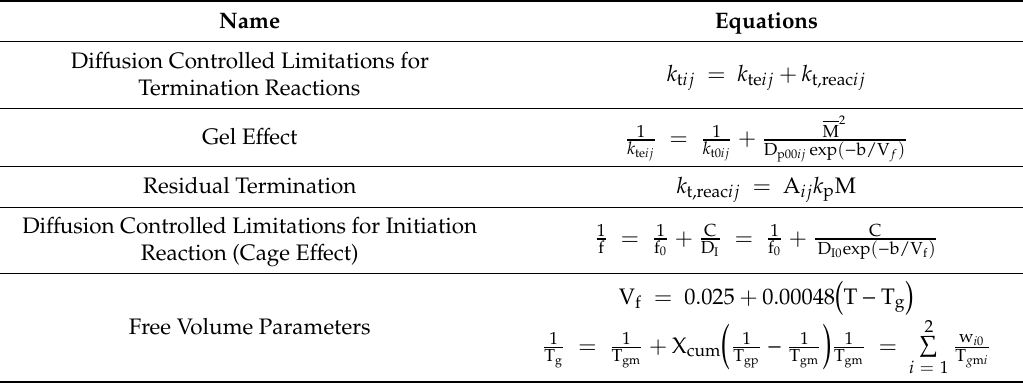
Table 1. Model Equations for Di ff usion-Controlled Copolymerization Reactions